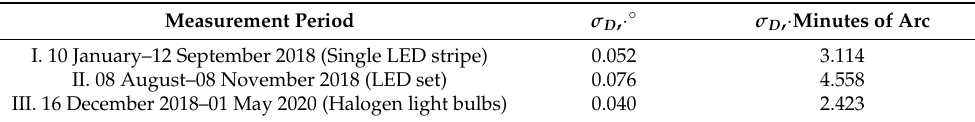
Table 7. Standard deviations of absolute magnetic declination values measured at the Klimovskaya observatory for three periods related to different lighting conditions in the absolute pavilion. See the details in Figure